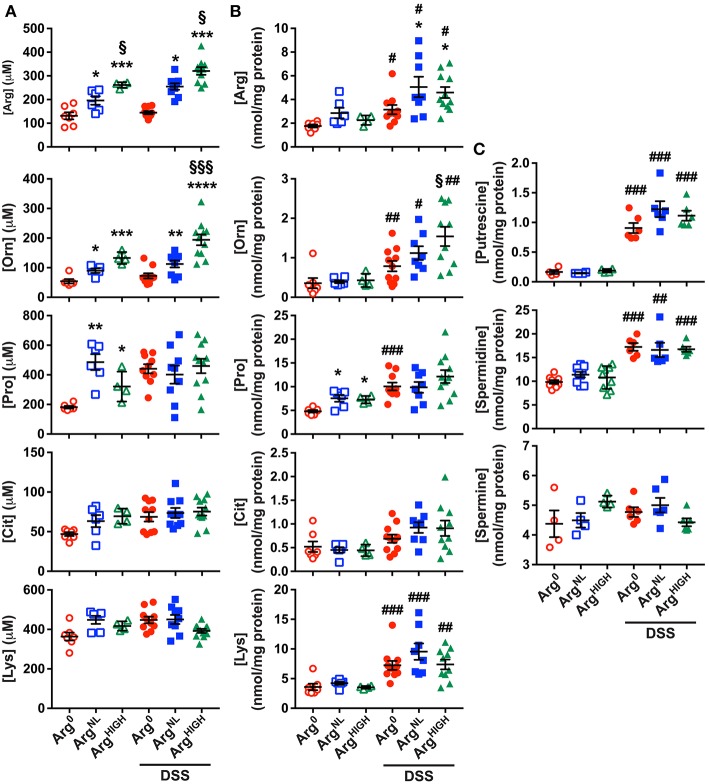
Amino acid and polyamine profiles during DSS colitis. (A,B) Concentration of amino acids in the serum (A) and in the colon (B) of mice. (C) The concentration of putrescine, spermidine, and spermine was determined by LC/MS in the colonic tissues. In all panels, #P < 0.05, ##P < 0.01, and ###P < 0.001 denote significant differences compared to animals not treated with DSS; *P < 0.05, **P < 0.01, ***P < 0.001, and ****P < 0.0001 compared to DSS-treated mice on the Arg0 diet; §P < 0.05 and §§§P < 0.001 vs. DSS-treated mice on the ArgNL diet, by ANOVA with the Tukey test.